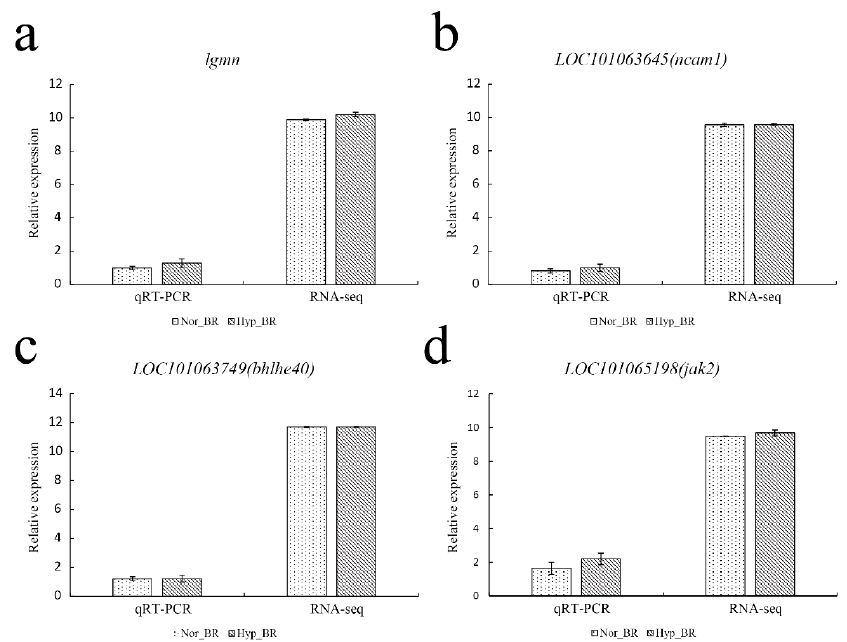
Figure 10. Quantitative real-time PCR verification. The gene expression levels were evaluated relative to the expression level of β -actin using the 2 −ΔΔ CT method. The correlation between normalized counts from RNA-seq and the relative expression from qPCR was calculated.